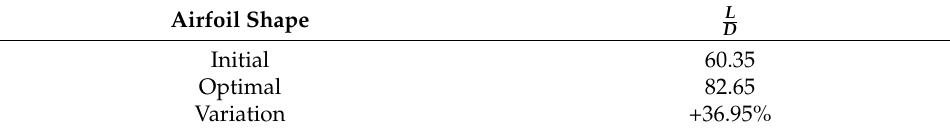
Table 8. The value of lift-to-drag ratio for the initial and optimal shapes (Test case I).